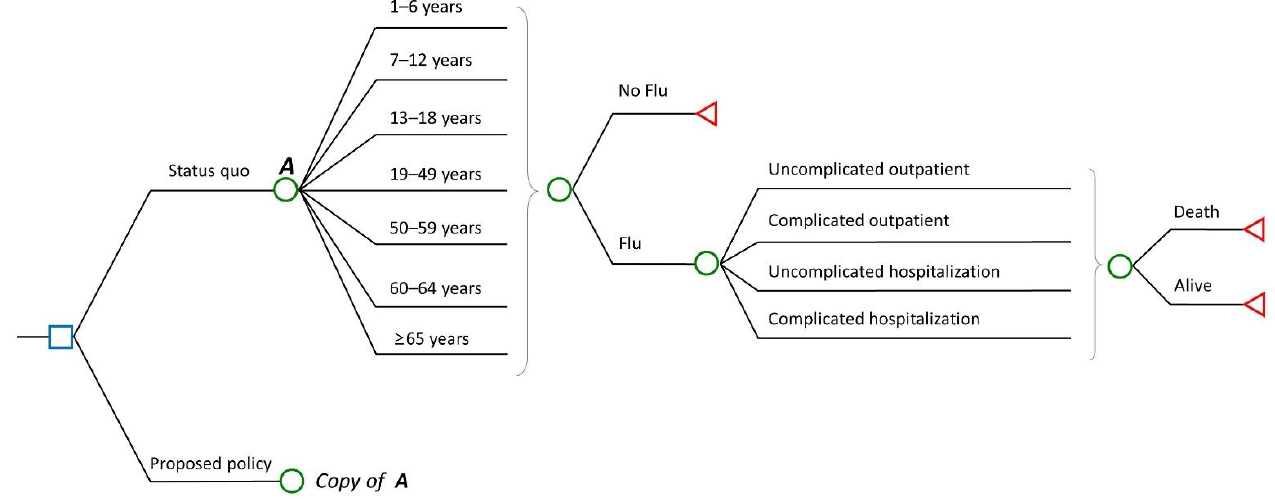
Figure 1. Economic model structure.